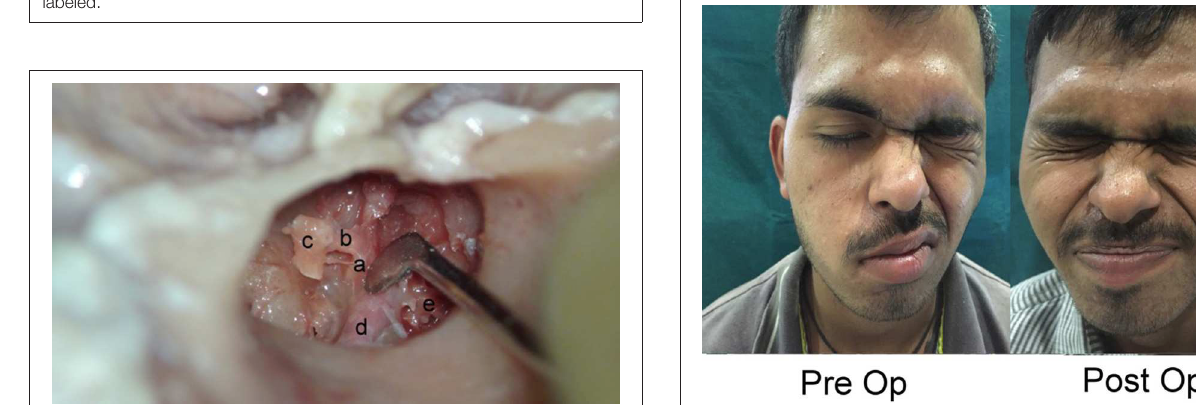
FIGURE 2 | Visualization of the supralabyrinthine region with exposure of the geniculate ganglion (left ear—cadaver). Incus body and malleus head have been removed. The cochleariform process (a) is being down-fractured with the attached tensor tympani tendon (b) and manubrium (c). Horizontal facial nerve (d) and supralabyrinthine area (e) are seen.